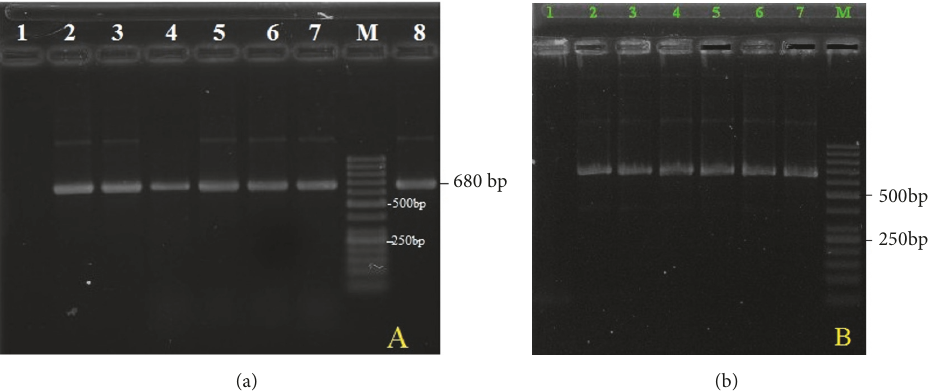
Figure 2: PCR patterns of amplified ITS1 ribosomal region. Lane M: 50 bp ladder molecular weight marker; lane 1 (a, b): negative control; lanes 2-8 (a) and 2-7 (b) denoted to different fluke samples amplified as a single band of 680 bp of bovine and buffalo in Nghe An province.